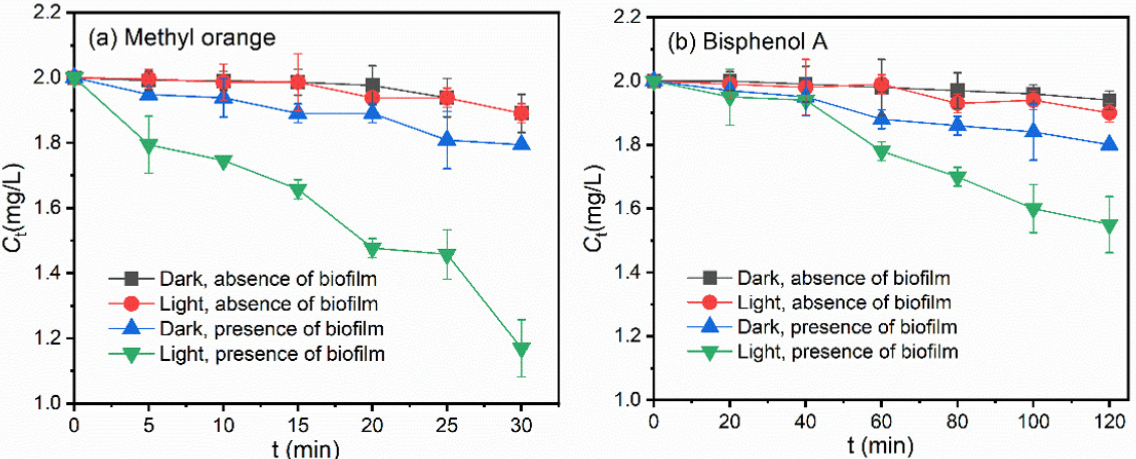
Figure 2. Effects of illumination and biofilm addition on the concentrations of ( a ) MO and ( b ) BPA in aqueous solutions.